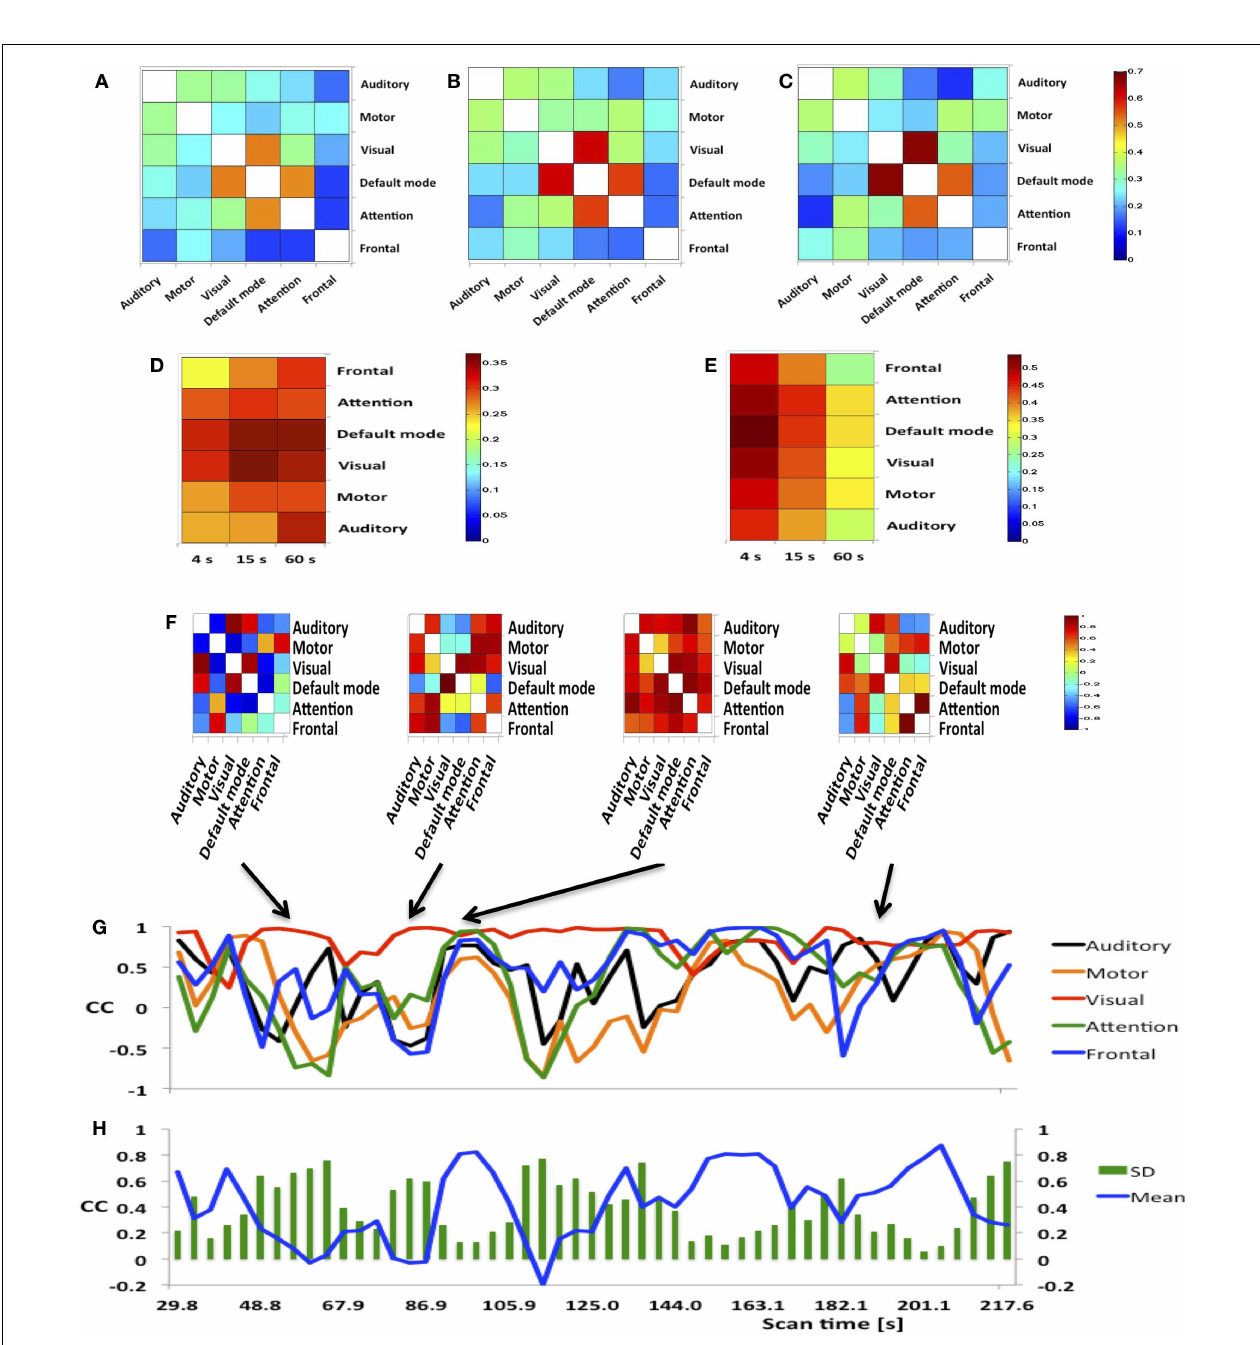
and 60s at the end of the scan. (F) Selected connectivity matrices for 15s sliding windows at time points of low (64, 83s), high (95s), and intermediate (190s) synchronization in a single subject. (G) Corresponding time courses of the correlations between the cuneus seed time course of the DMN and the seed time courses of five major task-positive RSNs within the sliding window. (H) Corresponding time courses of the mean and standard deviation of the correlation time courses in (G) as a metric of inter-network